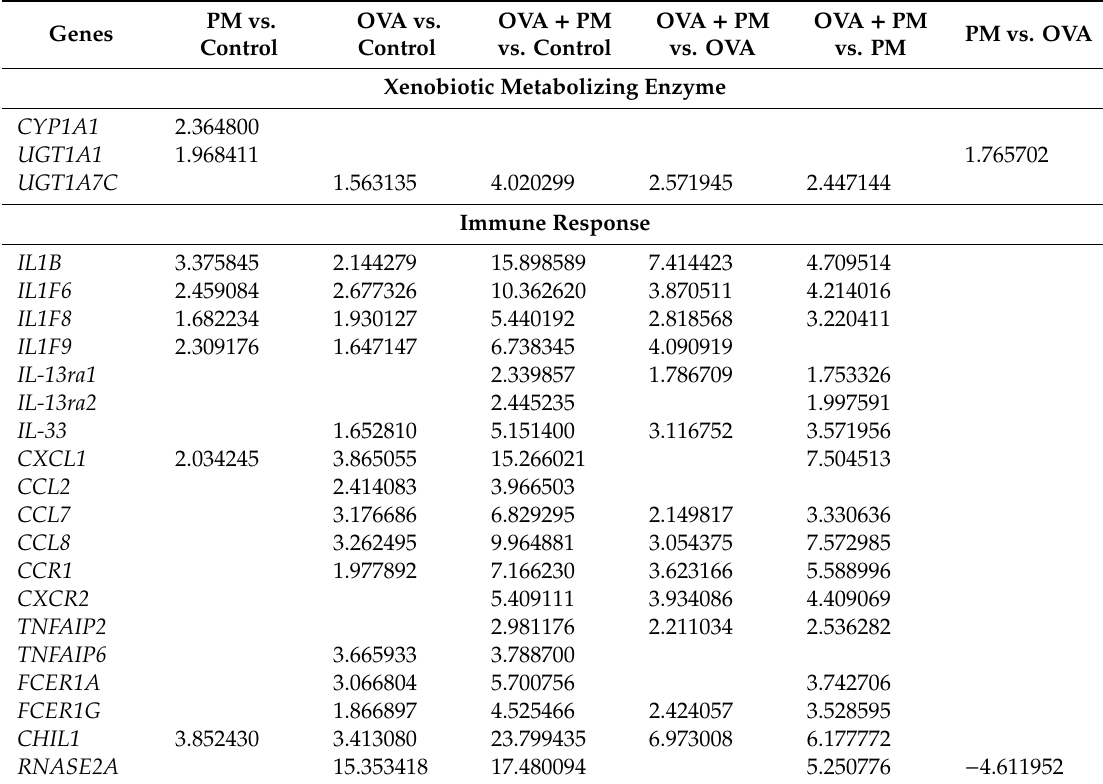
Table 2. DEGs according to their